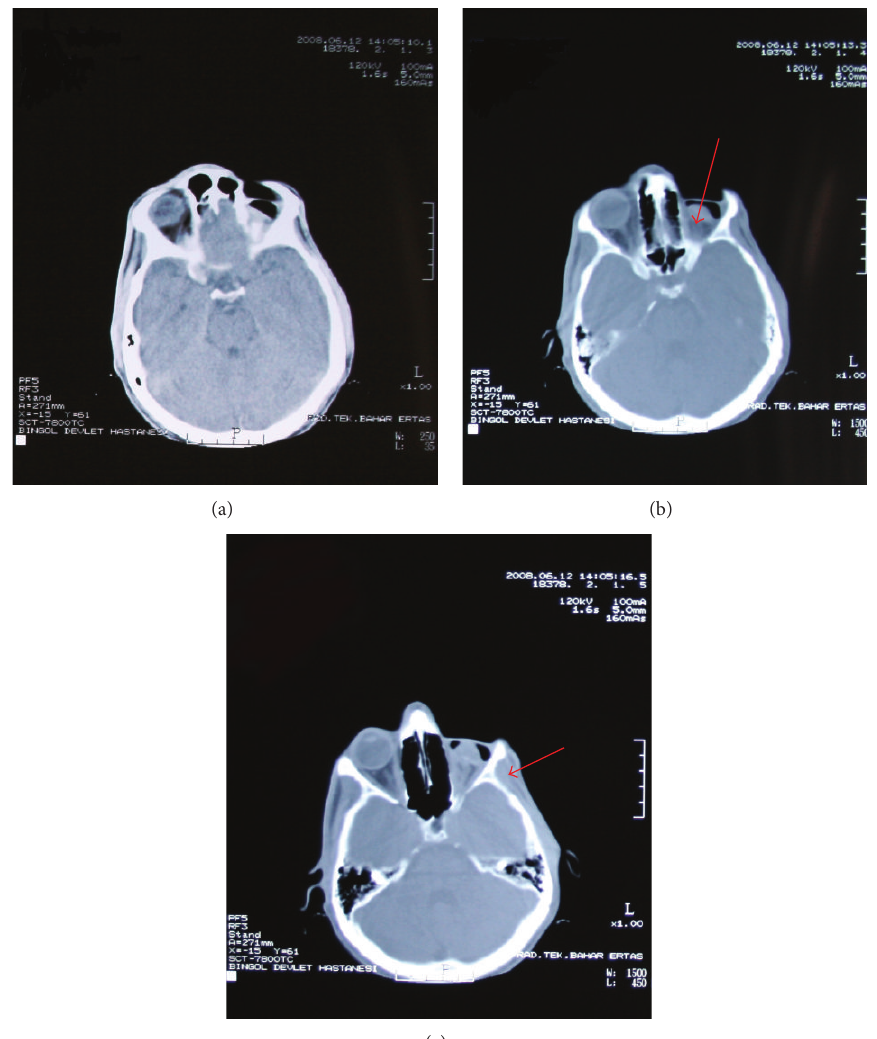
Figure 6: Axial computed tomography images of the head. (a) The bilateral hemispheres are normal in appearance. (b) Atrophy of the left retrobulbar fat tissue and phthisis of the eyeball (arrow) are evident. (c) The left temporal muscle (arrow) is